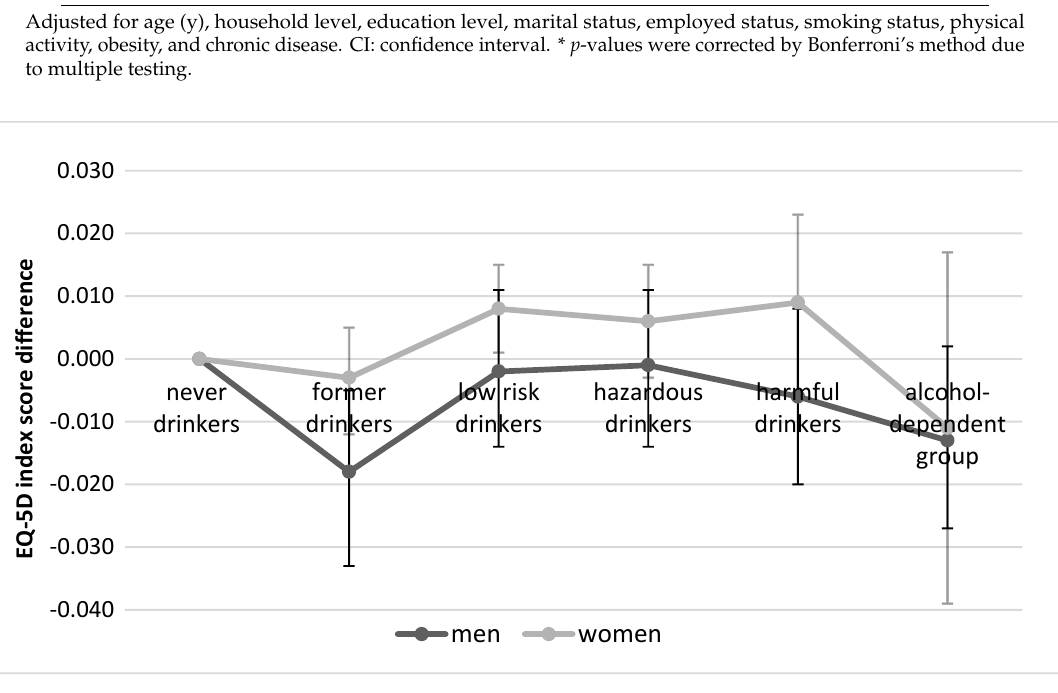
Figure 1. Adjusted EuroQol 5-Dimensions (EQ-5D) index score di ff erences associated with alcohol drinking patterns by gender.